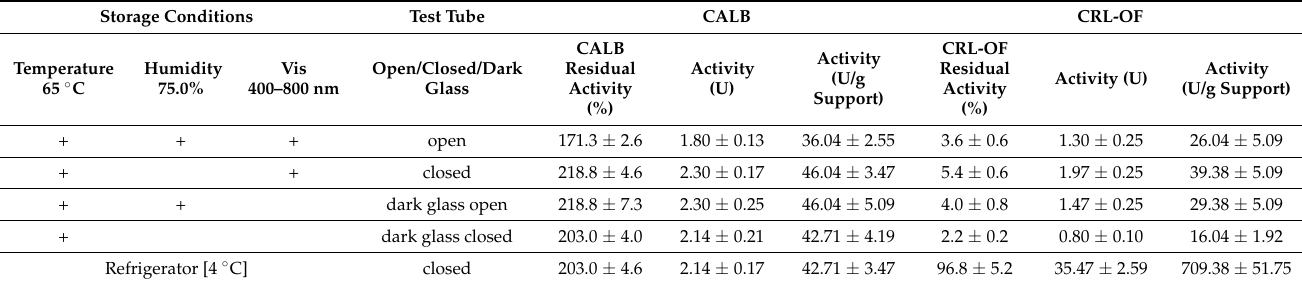
Table 2. Effect of storage conditions in the climatic chamber on the storage stability of the immobilized CALB and CRL-OF, in dry